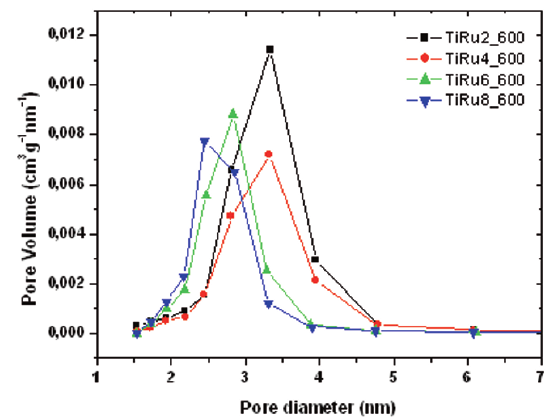
Figure 3. Pore size distributions of the doped titania samples (BJH method).